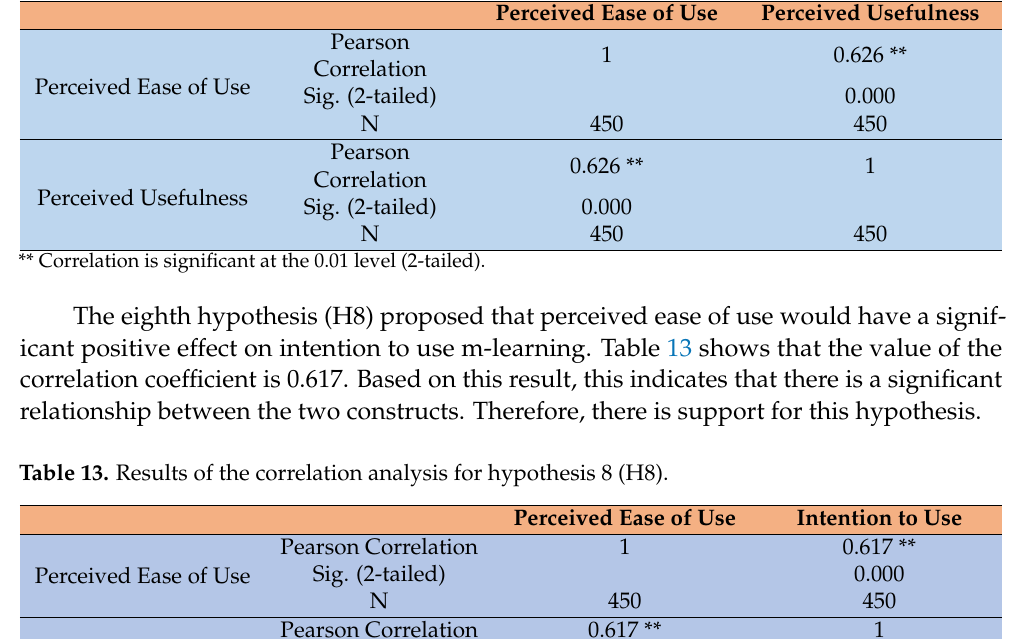
Table 12. Results of the correlation analysis for hypothesis 7 (H7).